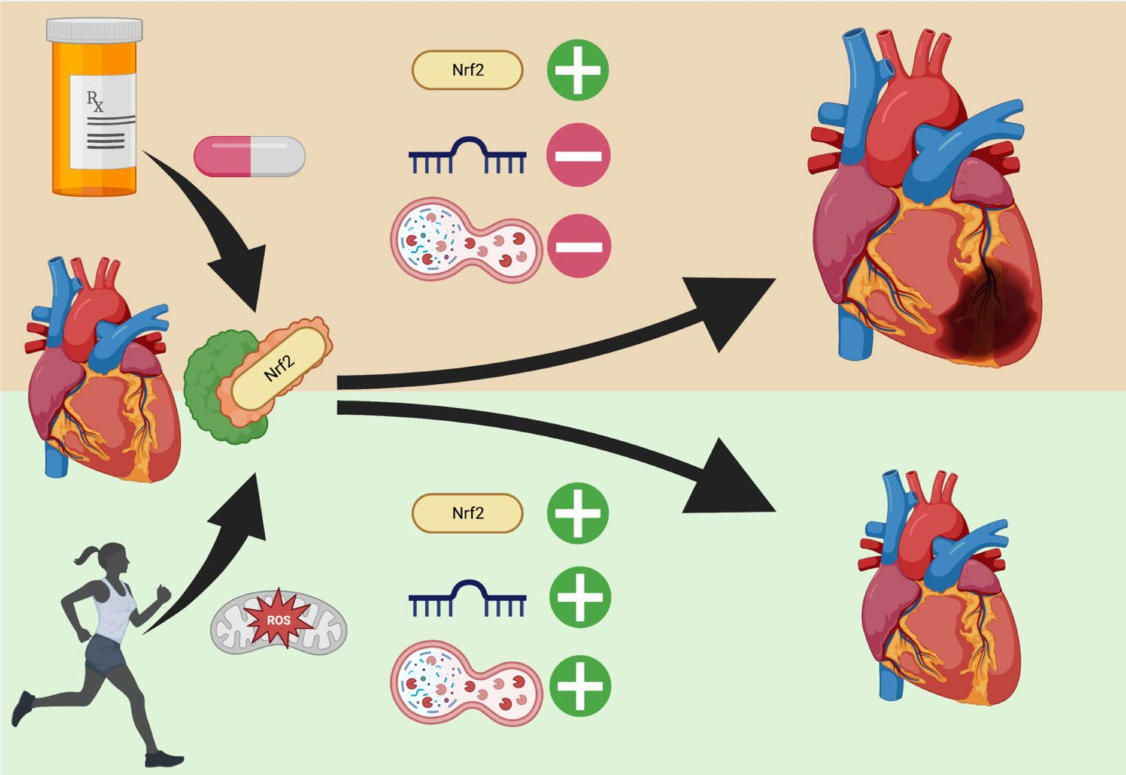
Figure 2. Exercise vs. Endogenous Nrf2 Regulators in the Heart. Exogenous regulators ( top ) increase Nrf2 levels through interaction with Keap1 but the effect on cardiac-related miRNA and autophagy is poorly studied. Conversely, exercise ( bottom ) upregulates not only Nrf2, but also pro- and anti- hypertrophic miRNA generation that allow for controlled remodeling. Additionally, autophagic enhancement removes the danger of necrosis from damaged organelles and reduces fibrosis from protein aggregates. Created in